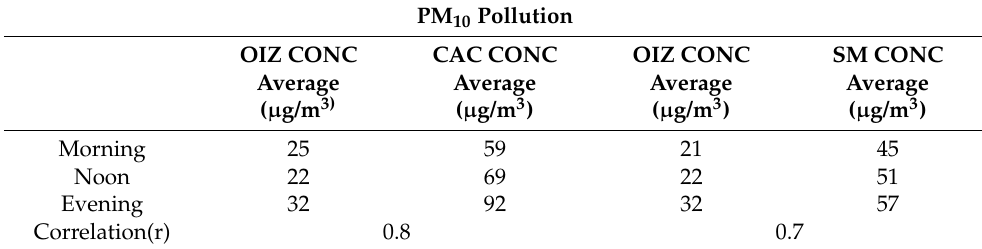
Table 4. PM 10 pollution correlation of OIZ, CAC and SM CONC